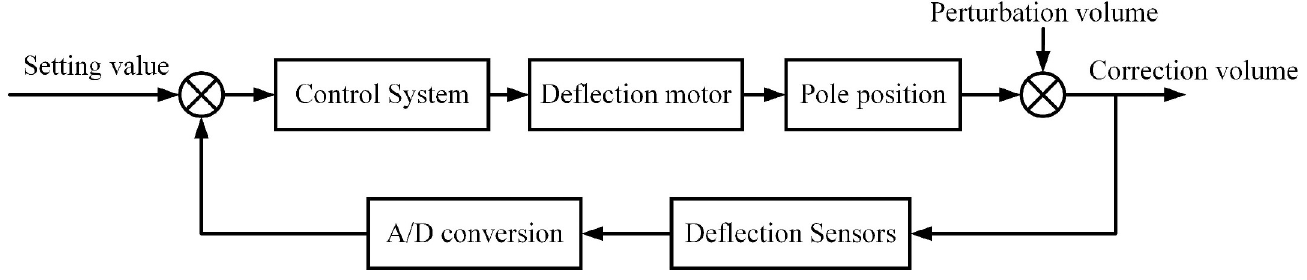
Fig 8. Corrective flow diagram.